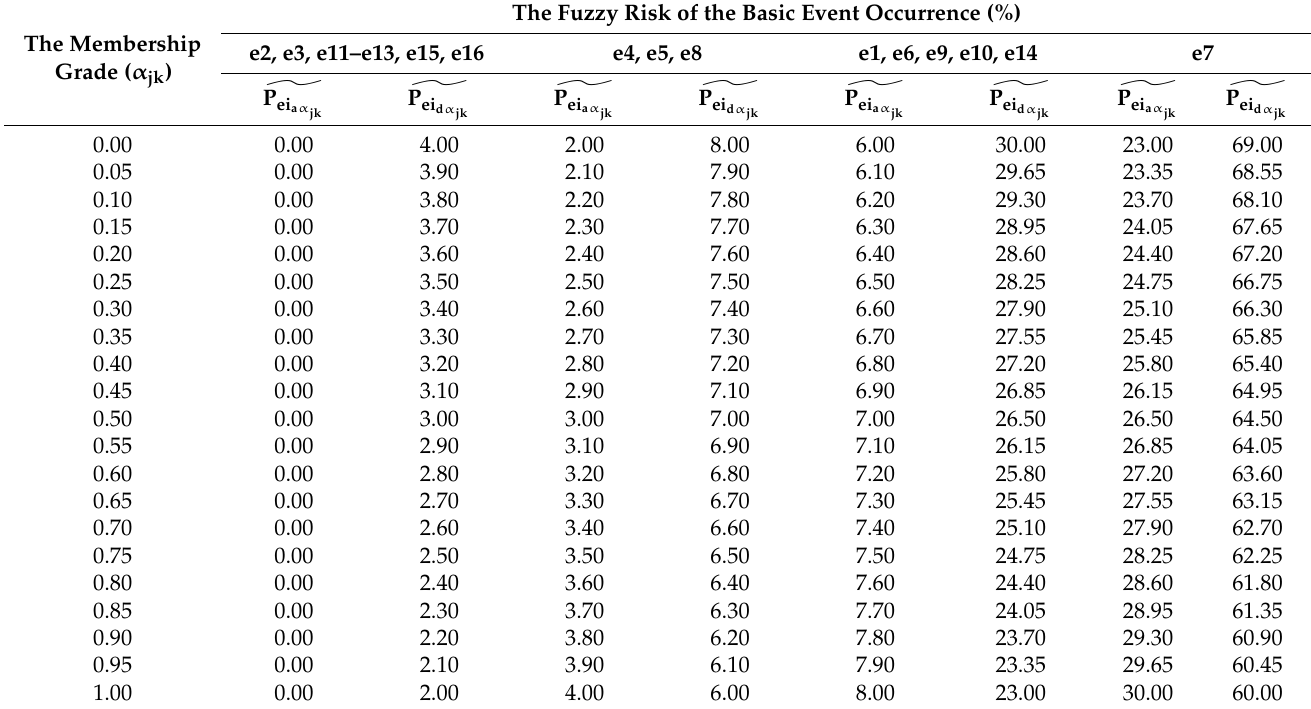
Table 8. The fuzzy risks connected with the BEs or UEs occurrence for the analyzed passive building project for various values of the membership grade for Alternative 1.